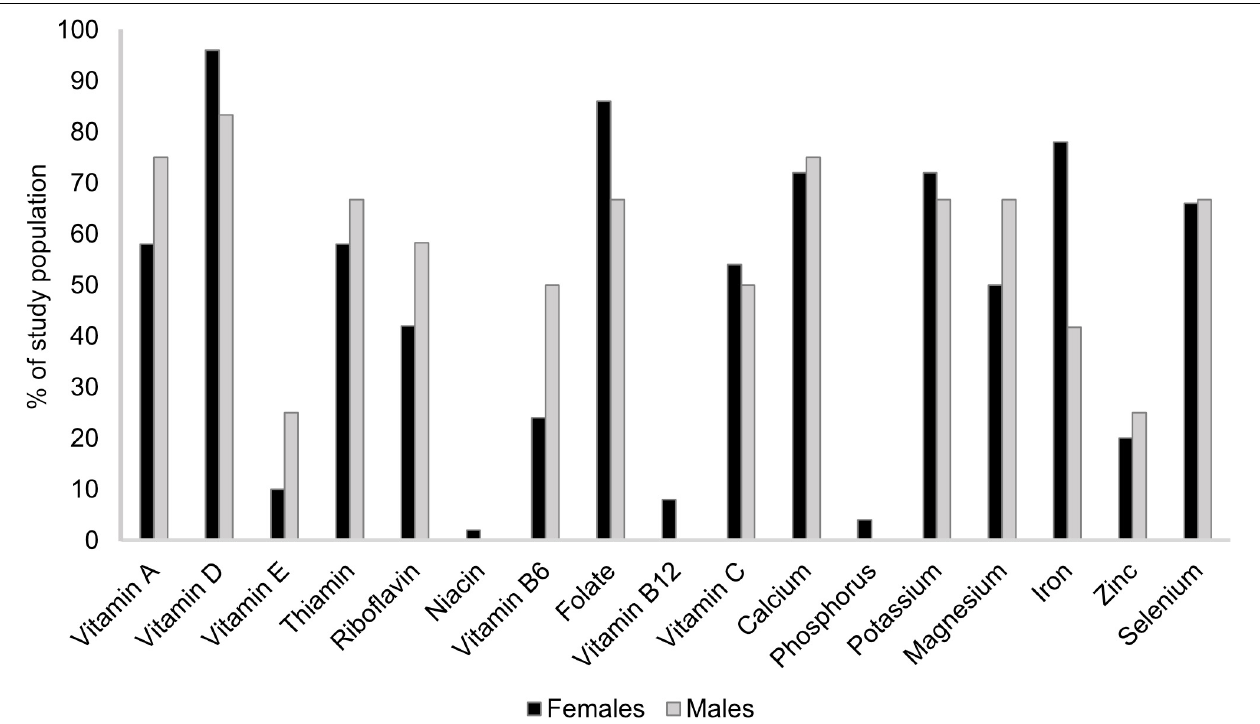
FIGURE 3 | Percentage of study population, 1 stratified by sex, reporting a micronutrient intake below recommended intake. 2 1 Patients with rheumatoid arthritis residing in southwestern Sweden (females n = 50, males n = 12). 2 Nordic Council Of Ministers (31). Nordic Nutrition Recommendations 2012: Integrating nutrition and physical activity [Internet]. Copenhagen: Nordisk Ministerråd; [cited 2021 1 November]. Available from http://urn.kb.se/resolve?urn=urn:nbn:se:norden:org: